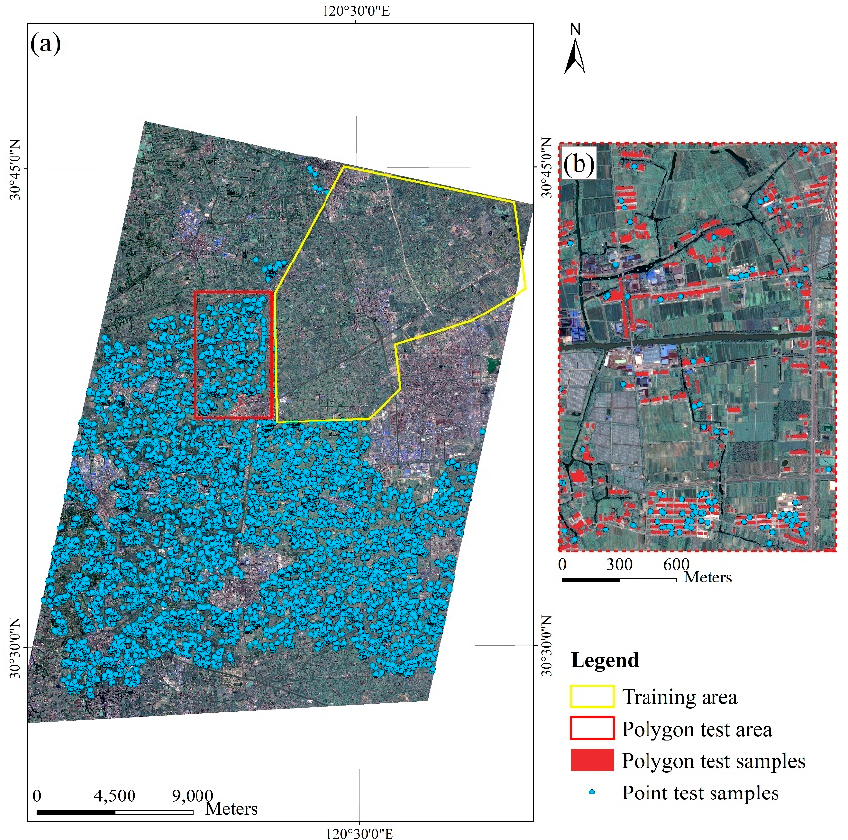
Figure 4. The ( a ) Tongxiang data set used in the experiments. ( b ) Example of test samples. Table 1. The number of testing